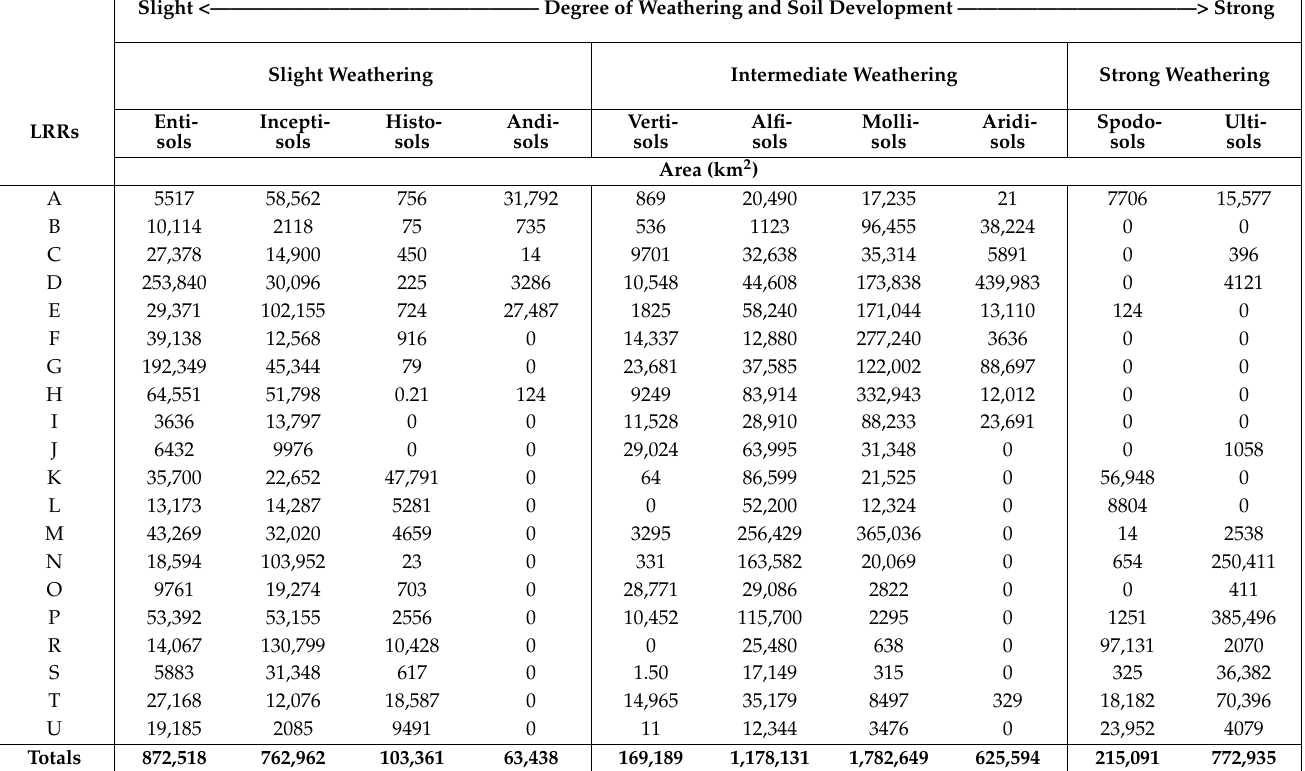
Table 9. Soil diversity (pedodiversity) by soil order (taxonomic pedodiversity) within Land Resource Regions (LRRs) for the contiguous United States (U.S.) Soil Survey Geographic (SSURGO) Database (2020) [27]. Slight <————————————————– Degree of Weathering and Soil Development ————————————>